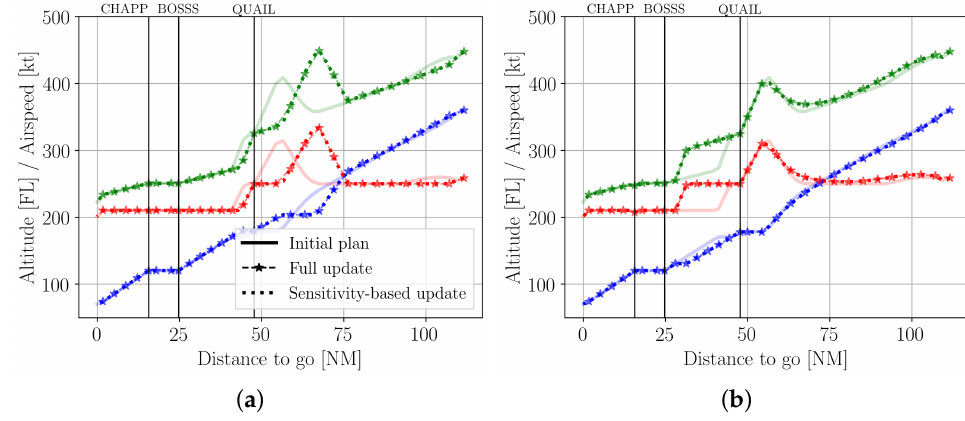
Figure 3. Optimal trajectory updates for perturbations in the parameters vector (21 April 2018 00:00 with a look-ahead time of +1 h). ( a ) δ c (actual minus forecast of Figure 2). ( b ) δ CTA =